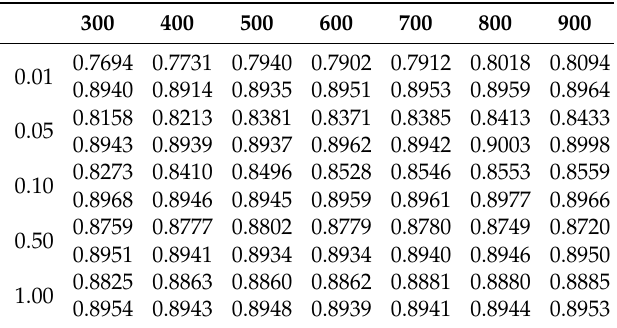
Table 5. OA on different values of sparsity and number of hidden nodes over Xi’an area image by two classification networks based on AE and the proposed MAE.